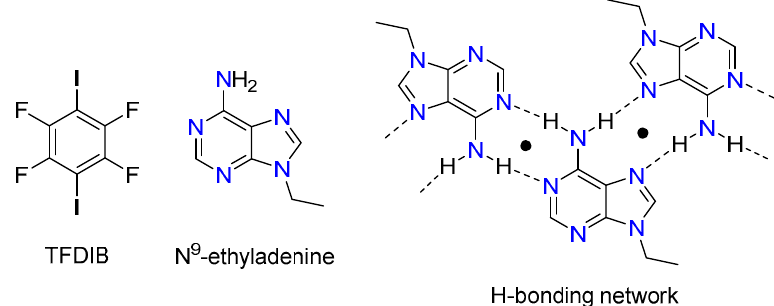
Figure 1. Molecular structures of 1,2,4,5-tetrafluoro-3,6-diiodobenzene (TFDIB, left), N 9 -ethyladenine (middle), and an H-bonding network with indication of the two possible centrosymmetric H-bonds (right).